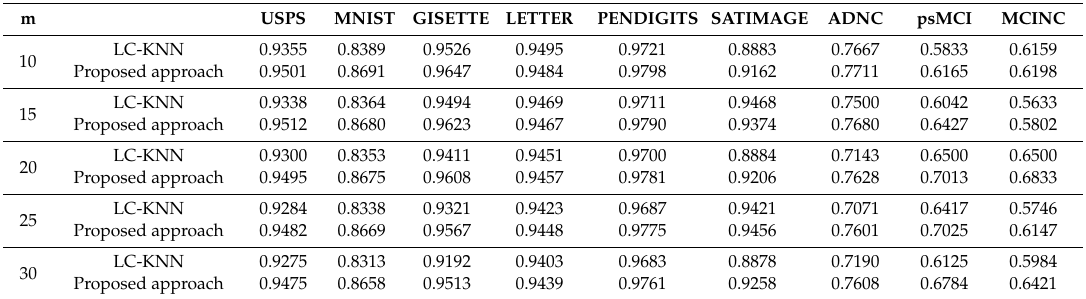
Table 2. Classification accuracy (mean of 10 runs) of the proposed approach and LC-KNN algorithm at di ff erent values of the m